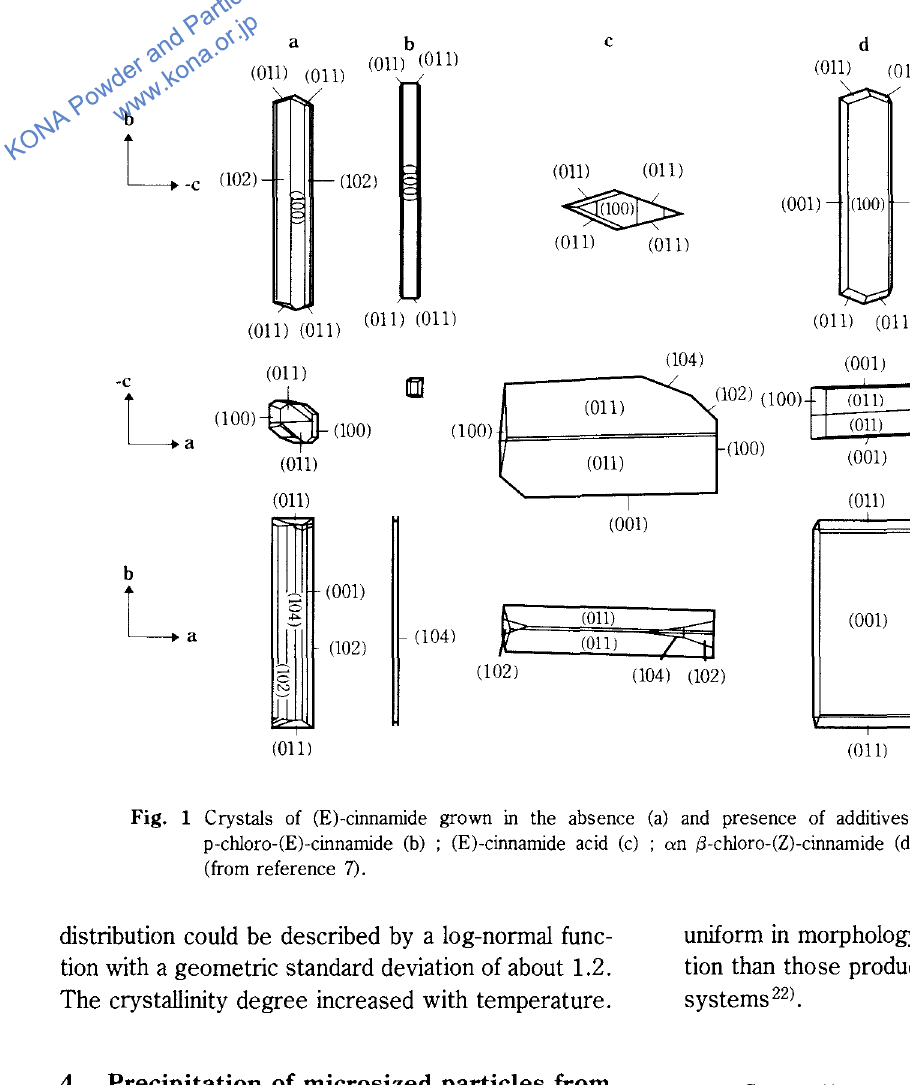
Fig. 1 Crystals of (E)-cinnamide grown in the absence (a) and presence of additives : N-methyl-(E)-cinnamide of p-chloro-(E)-cinnamide (b) ; (E)-cinnamide acid (c) ; an {3-chloro-(Z)-cinnamide (d) ; o-chloro-(E) cinnamide (e) (from reference